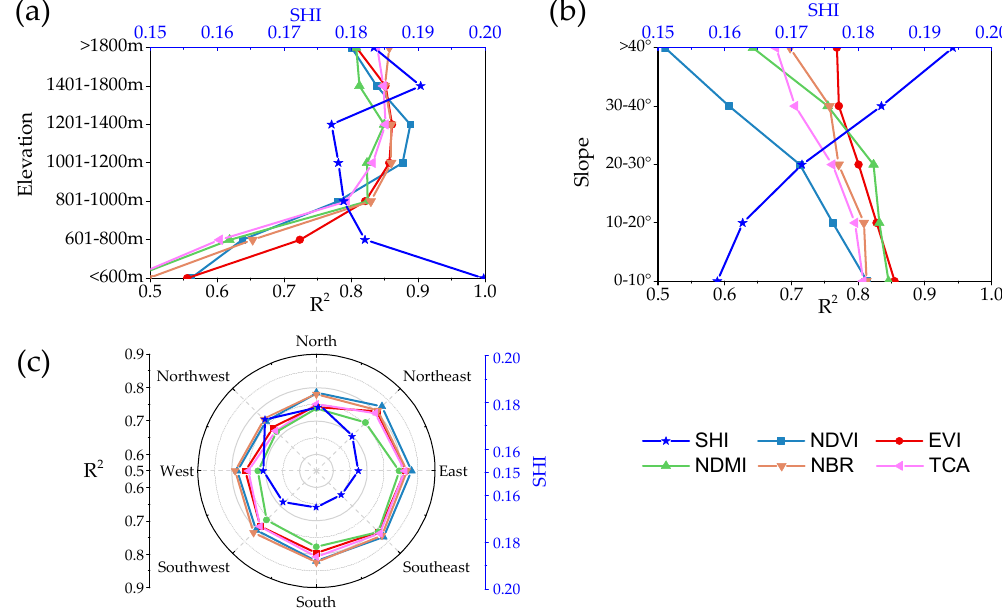
Figure 7. Fusion accuracy and SHI of different TFs: ( a ) Elevation; ( b ) Slope; ( c ) Slope aspect. Table 9. Correlation between fusion accuracy and